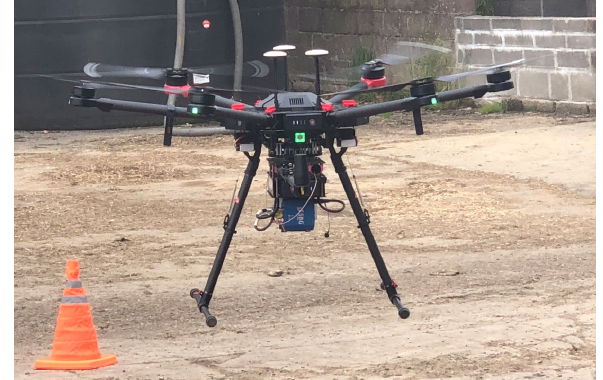
Figure 5. The Matrice 600 Pro SUA carrying the Robin Mini.